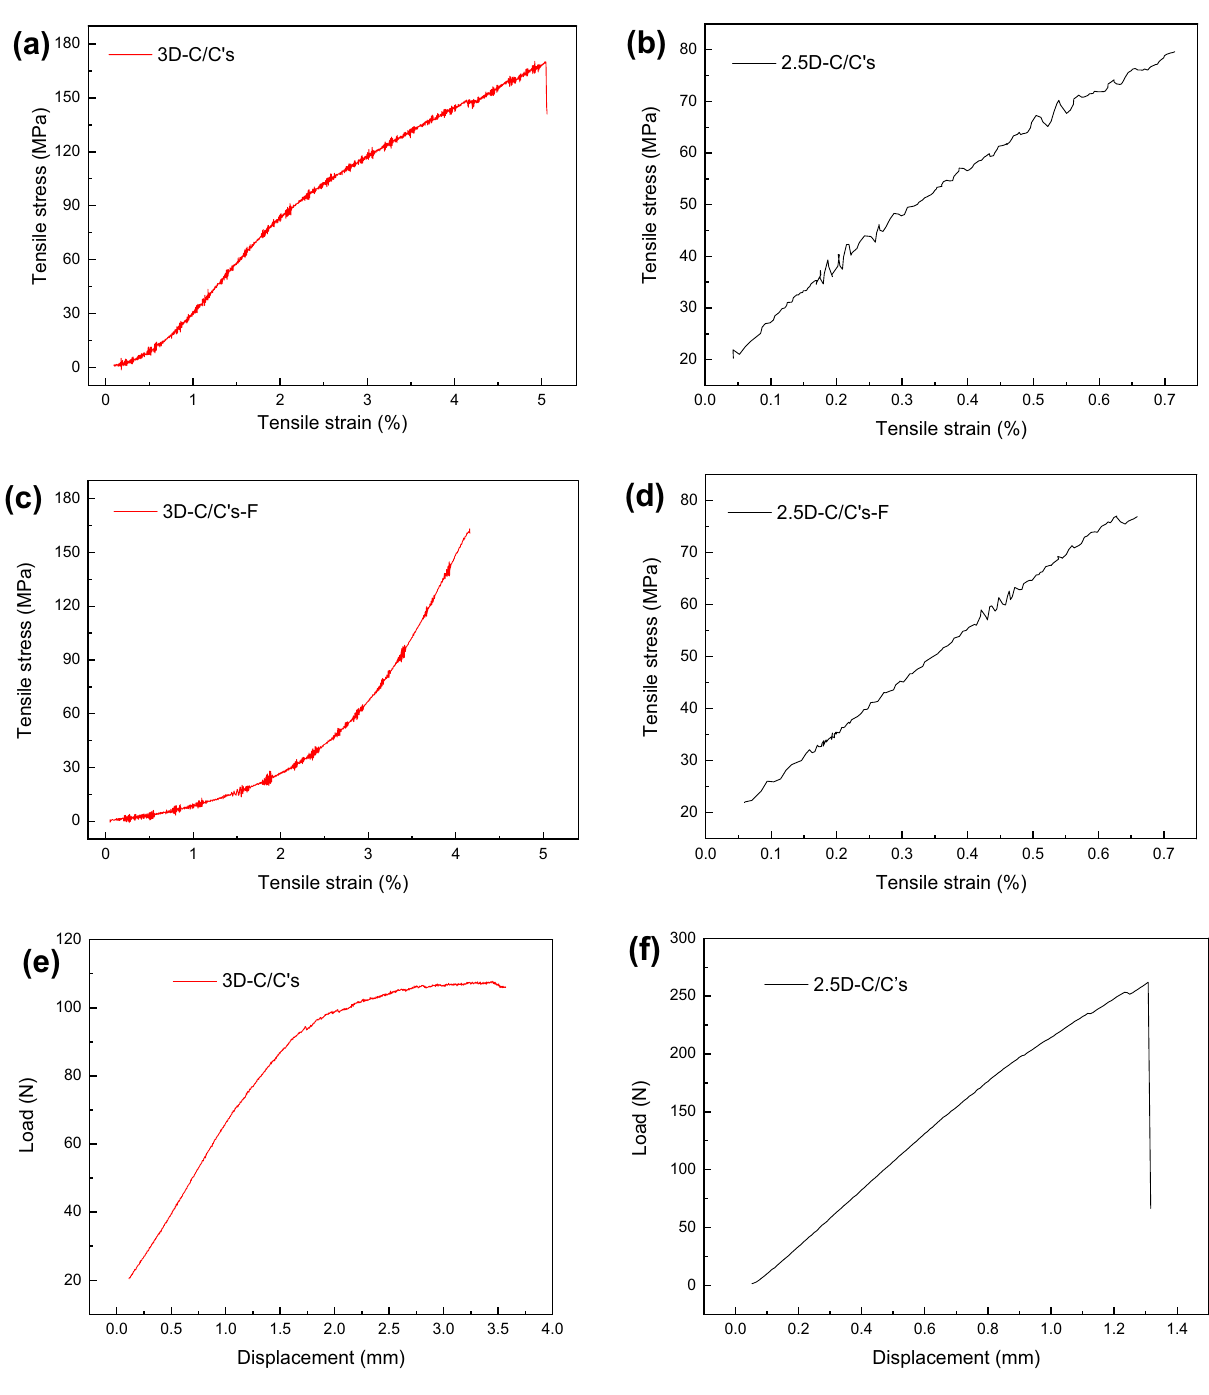
Figure 4. Mechanical properties curve of C/C composites, tensile, ( a ) 3D-C/C composites, ( b ) 2.5D-C/C composites under static condition; ( c ) 3D-C/C composites, ( d ) 2.5D-C/C composites after fatigue; flexural, ( e ) 3D-C/C composites, ( f ) 2.5D-C/C composites,